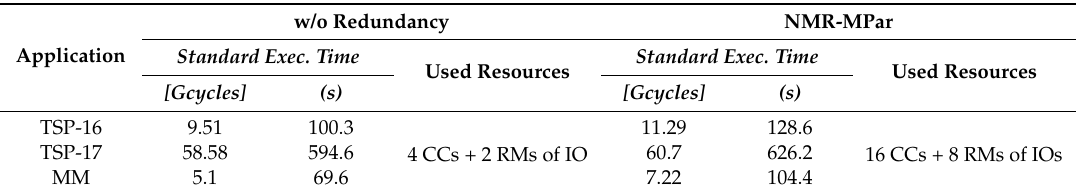
Table 3. Benchmark characteristics for each